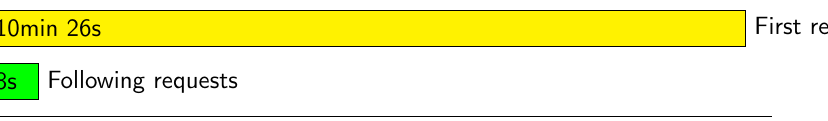
Figure 6. Answer times on first request and next requests.